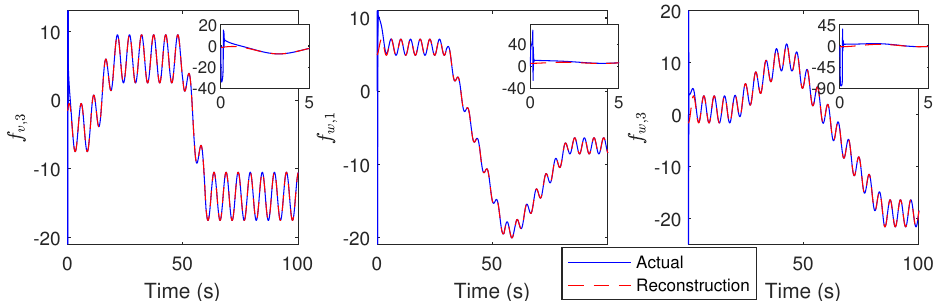
Figure 5. The faults affecting system (53) (solid) and their estimates from the central SMO (dashed) for the case u cc = 0.